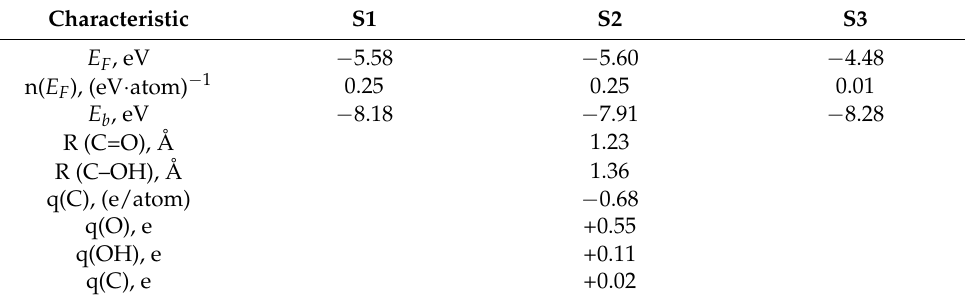
Table 2. Electronic characteristics of functionalized